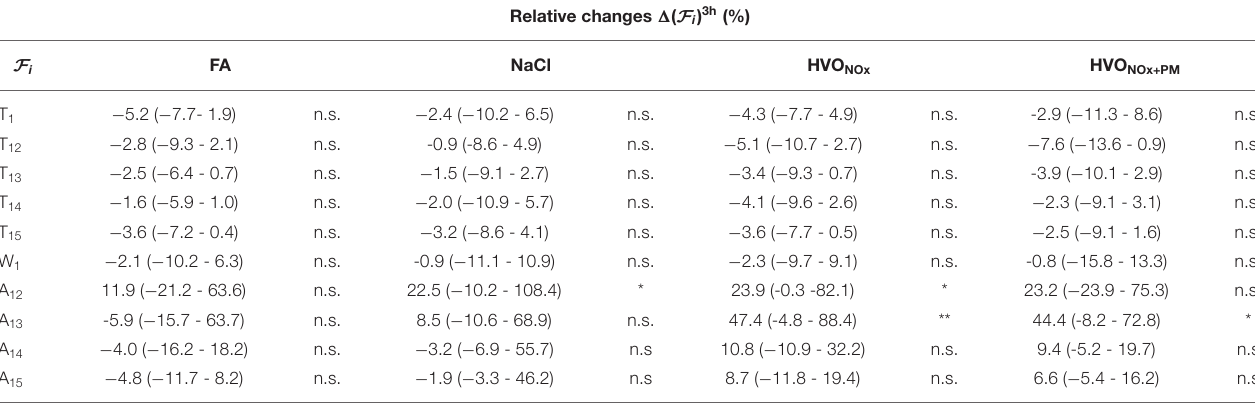
TABLE 2 | Median and interquartile range (Q 1 -Q 3 ) of relative changes 1 ( F i ) 3h in PDA features for each exposure scenario.